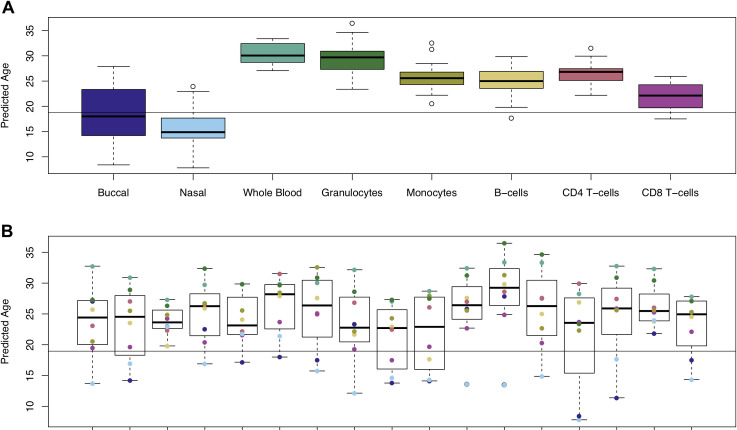
Age estimates derived from DNA methylation data vary across different sample types from the same individual.A) Boxplots of predicted age using the Horvath epigenetic clock (Horvath 2013), with samples grouped by sample type. Predictions for each sample type had a mean range of 12.1 years (SD 4.24). B) Boxplots of predicted age grouped by individual, where the color indicates the value derived from a specific sample type from that individual. Predictions for each individual had a mean range of 16.4 years (SD = 4.29). The line shows the actual age of the samples (19 years old).